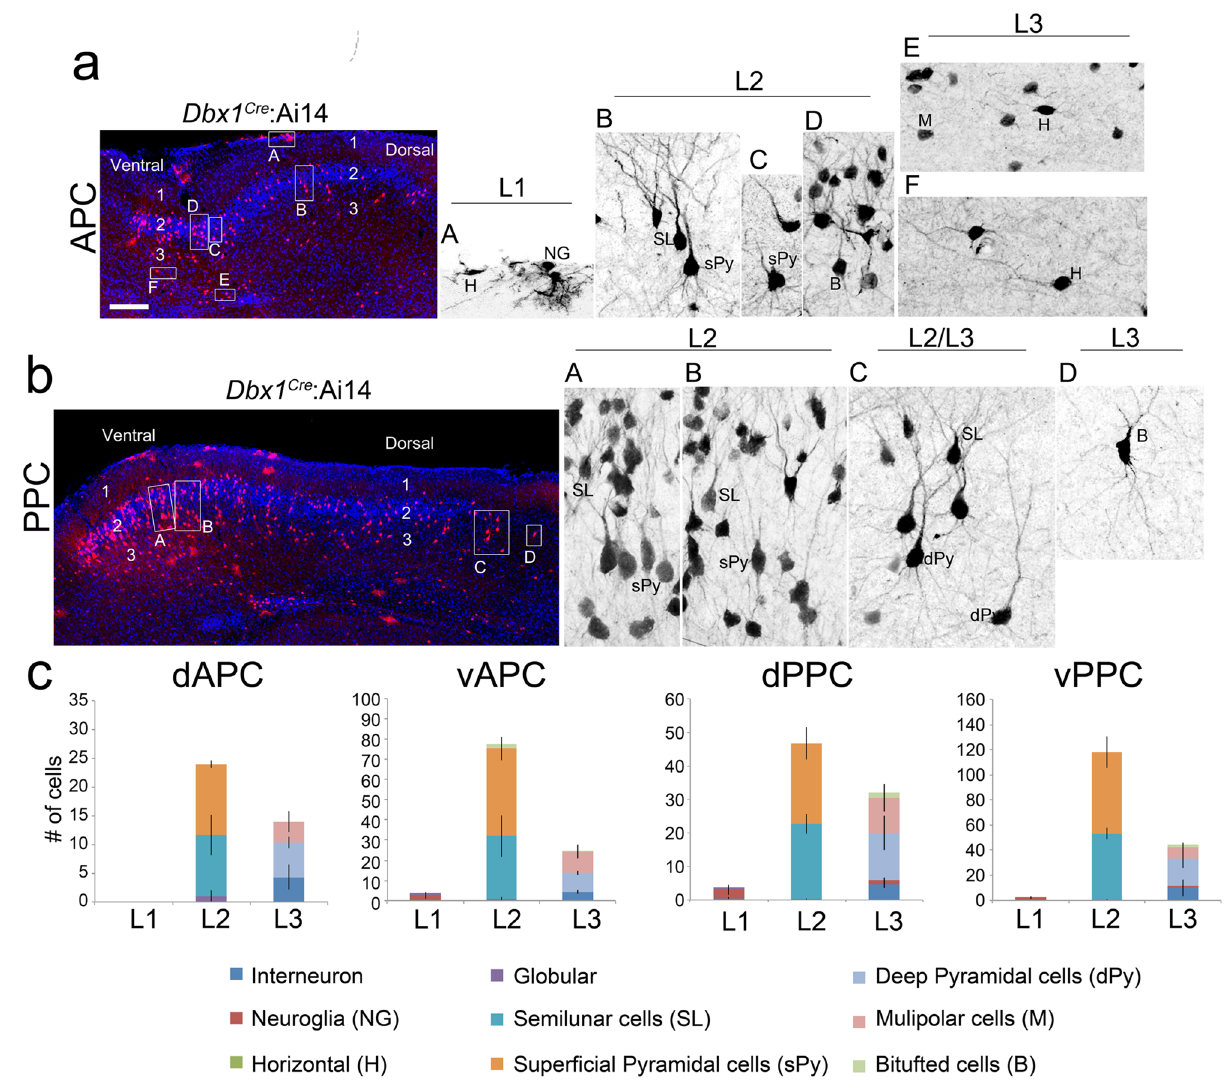
Figure 4. Morphologies of neurons of the Dbx1 lineage. ( a , b ) Morphologies of neurons from the Dbx1 lineage were observed in coronal sections of the APC ( a ) and PPC ( b ) of Dbx1 Cre :Ai14 cortices at P30. Higher magnifications of insets are shown on the right. Different cell types were identified based on their morphologies. ( c ) Quantification is shown for cells of each type in different sub-regions of the APC and PPC (n = 3). Scale bar, 100